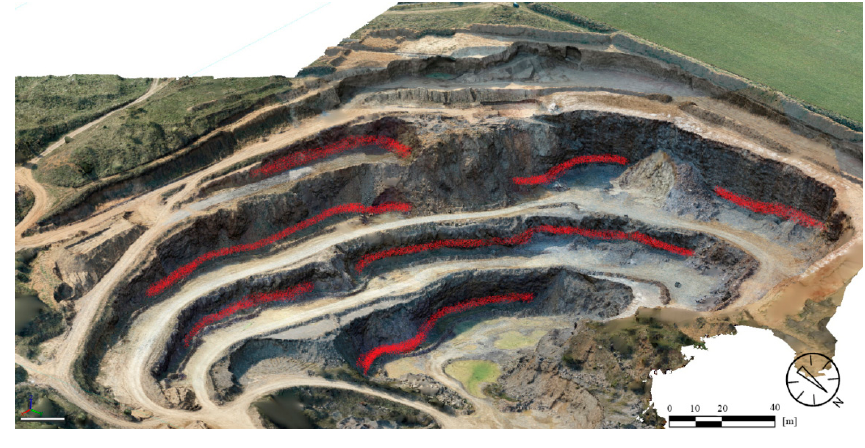
Figure 8. Parts of quarry faces where field structural geological measurements were possible (red markings). All other parts were inaccessible, and TLS and UAV were used to identify structural elements such as fault planes. The combined data set was used in the structural geological survey. In the created contour line map and images as well as the quarry surfaces, the major fault zones were identified. These zones